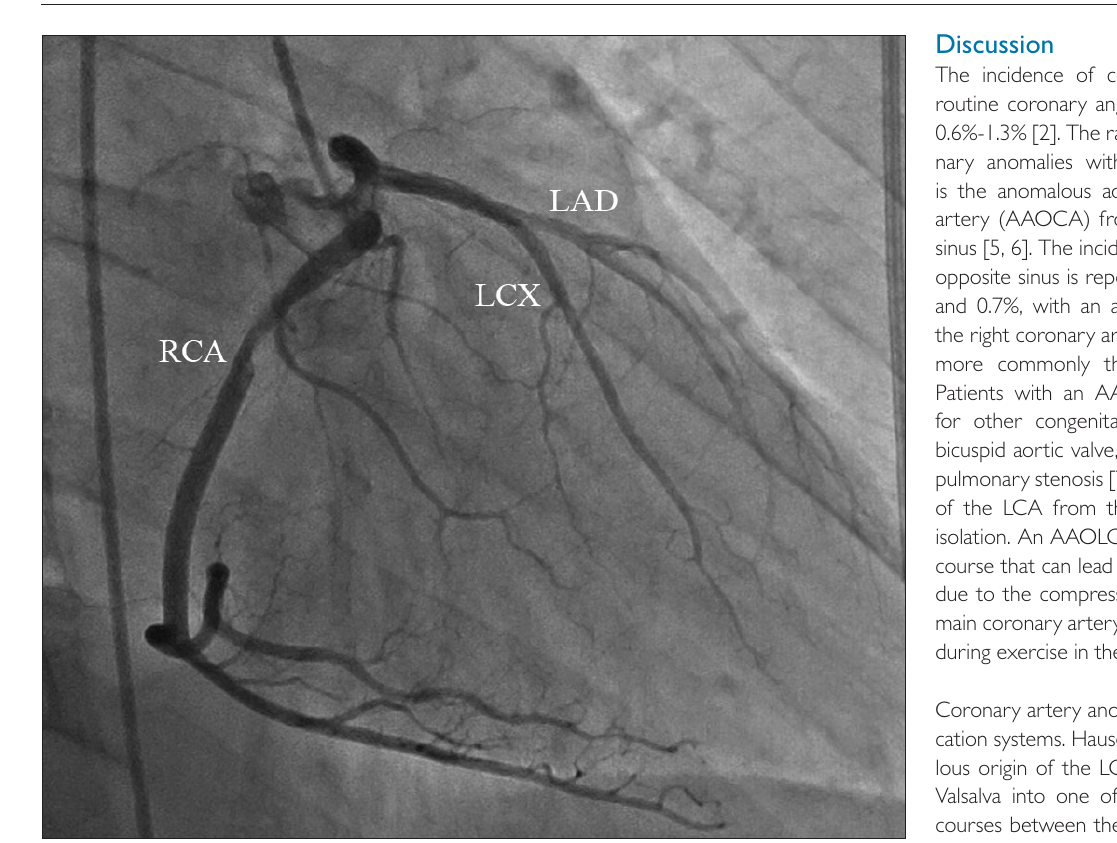
Figure 1. Coronary angiography image (right anterior oblique view) showing the anomalous left main coronary originating from a common trunk. RCA: right coronary artery; LAD: left anterior descending; LCX: left circumflex